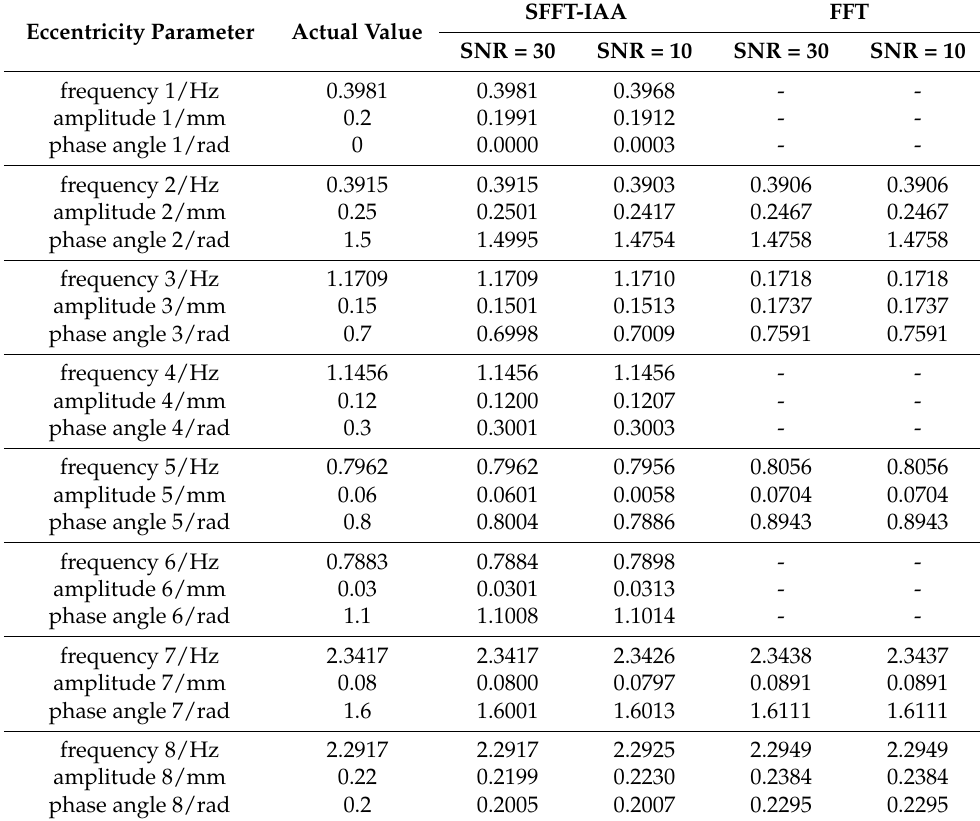
Table 1. The simulation results of eccentricity signal